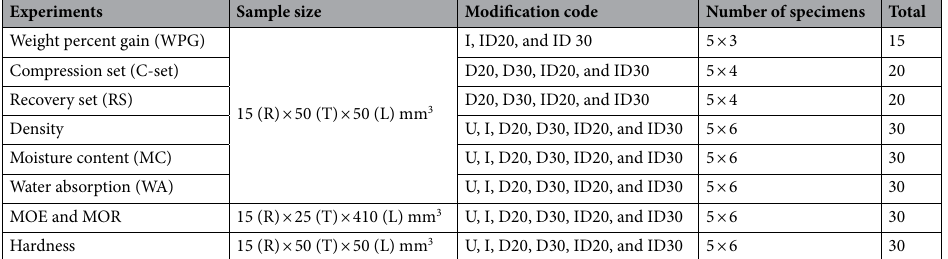
Table 2. Sample information for evaluating the physical and mechanical properties of modified IOPT. *R: Radial direction; T: Tangential direction; L: Longitudinal direction; U = Untreated; I = Impregnation; D20 and D30 = Densification with compression ratio (CR) 20% and 30%, respectively; ID20 and ID30 = compregnation with CR 20% and 30%, respectively.